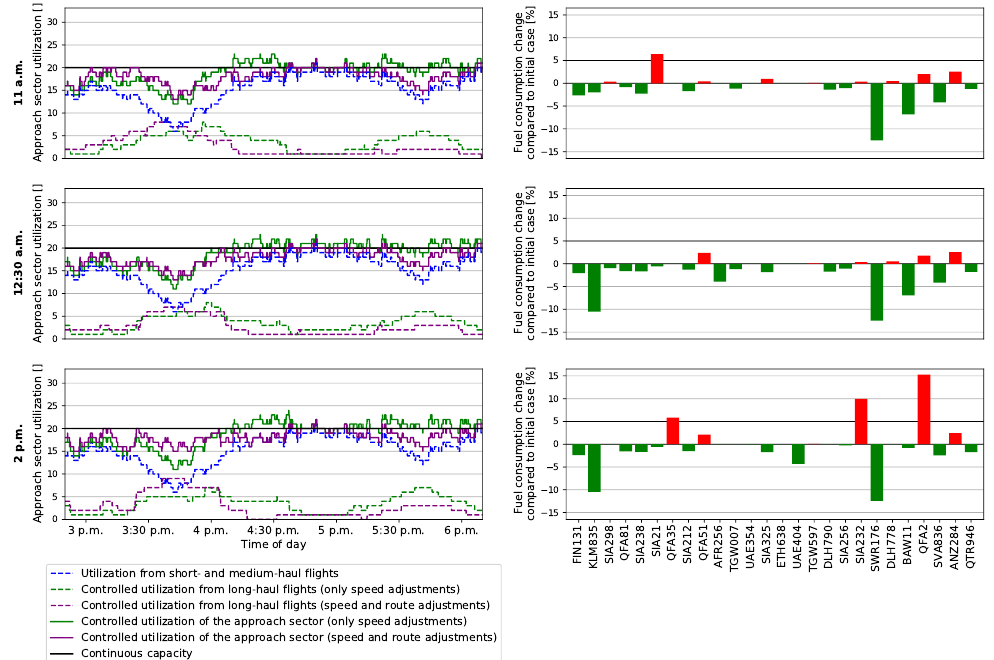
Figure 11. Left : Optimization results using LR-ATFM with speed and route adjustments compared to the optimization results using LR-ATFM with only speed adjustments. Right : Fuel change compared between the usage of LR-ATFM with speed and route adjustments to the initial case with no LR- ATFM